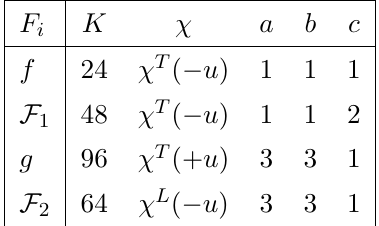
Table 3 . Inputs entering φ i ( t ; t 0 ) in eq. (5.8) for the meson form factors F i